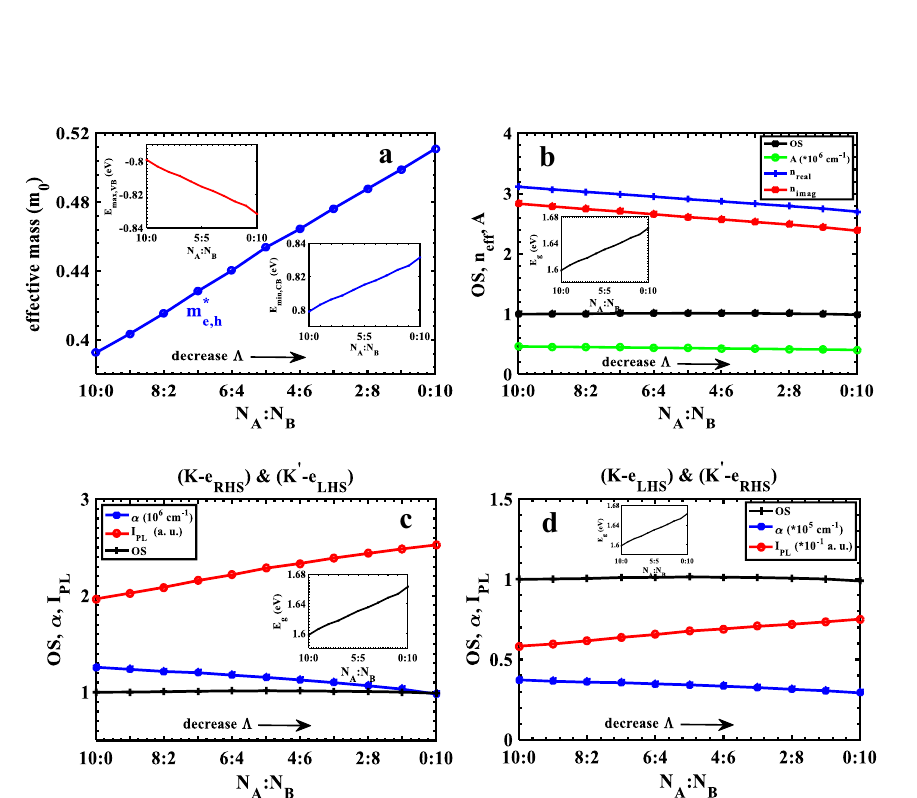
valley with up and down − e RHS and e LHS and ( d ) e LHS , e RHS , (cid:31) (cid:31) (cid:31) (cid:31)